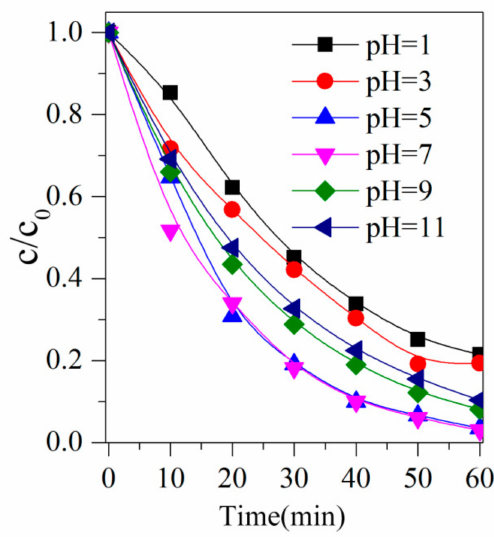
Figure 6. E ff ect of pH on degradation; [IL] = 0.1 mM, t = 45 °C, [H 2 O 2 ] = 100